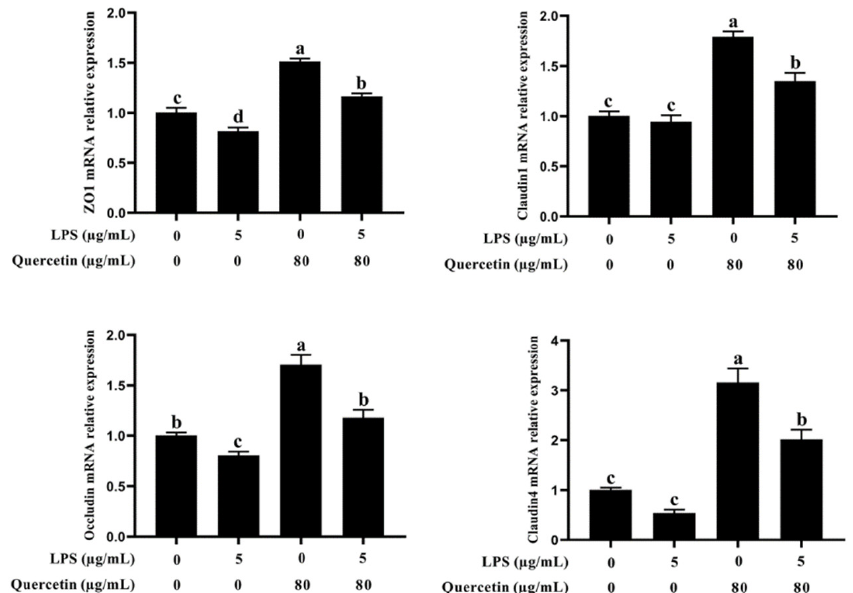
Figure 3. Impact of quercetin on barrier function in LPS-induced BIECs. BIECs were treated with 80 µ g/mL quercetin in the environment of 5 µ g/mL LPS for 6 h; The mRNA representation of zo-1, occluding, claudin 1, and claudin 4 in BIECs was examined by qRT-PCR. The results are mean ± SEM (n = 6). Various lowercase letters in the line graph reveal significant changes ( p < 0.05).